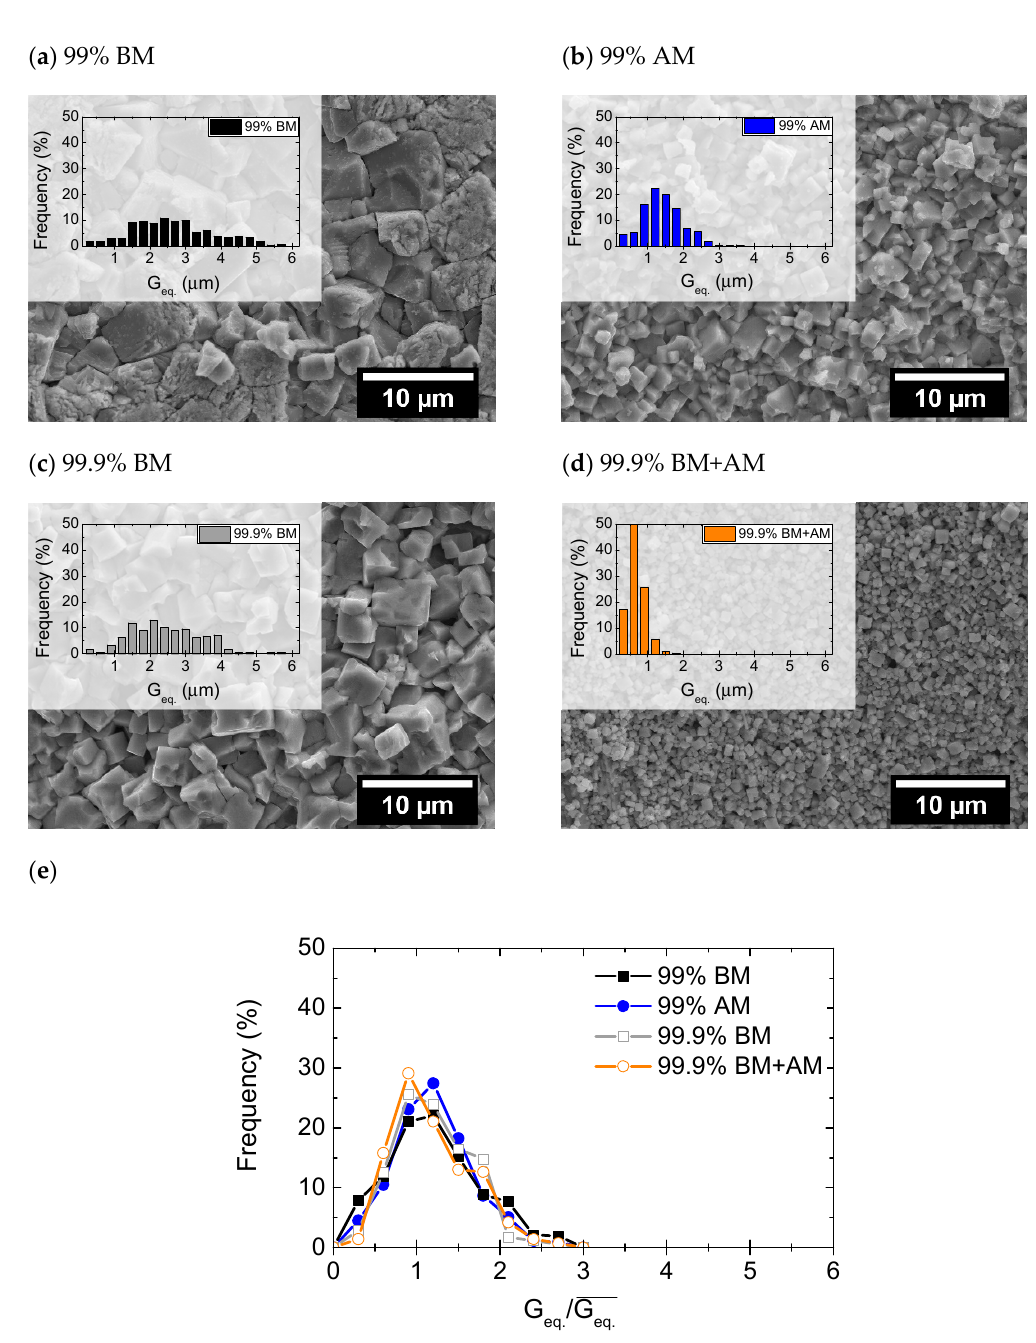
Figure 4. SEM micrographs of FLASH-sintered ceramics from ( a ) 99% BM, ( b ) 99% AM, ( c ) 99.9% BM, and ( d ) 99.9% BM+AM powders, with overlapped respective measured equivalent grain size (G eq. ) distribution, and ( e ) representation of the normalized (with the respective G eq. ) grain size distribution.